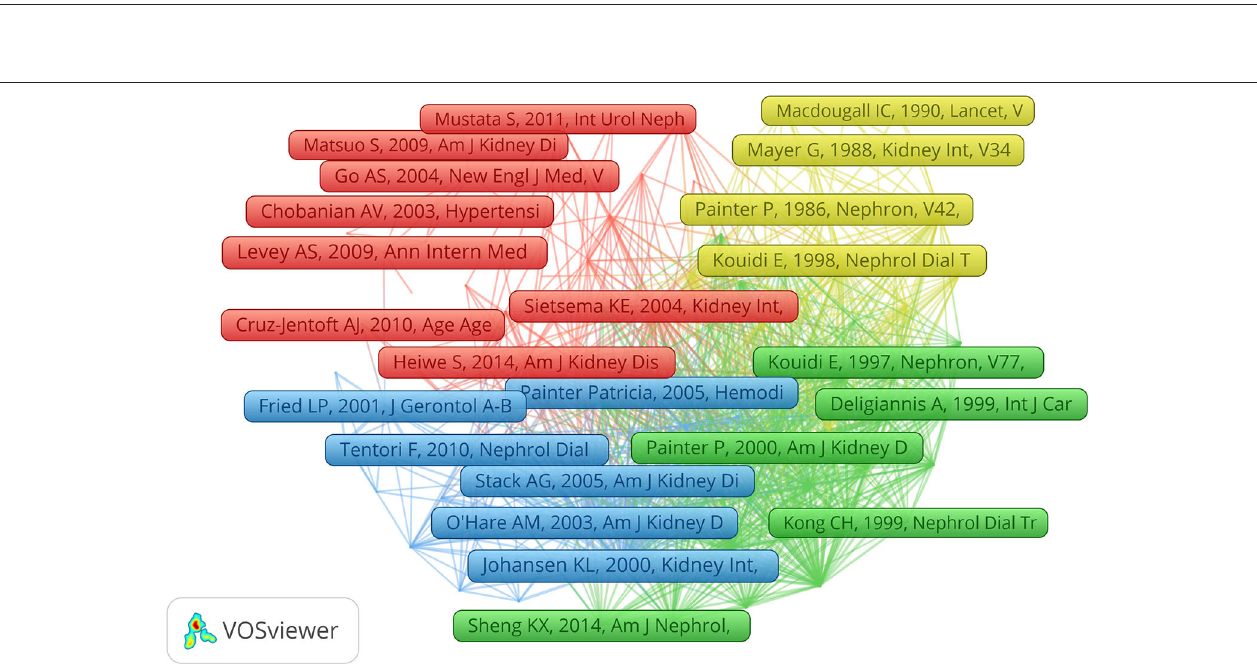
FIGURE 6 | Network map of co-citation of references with more than 50 citations.